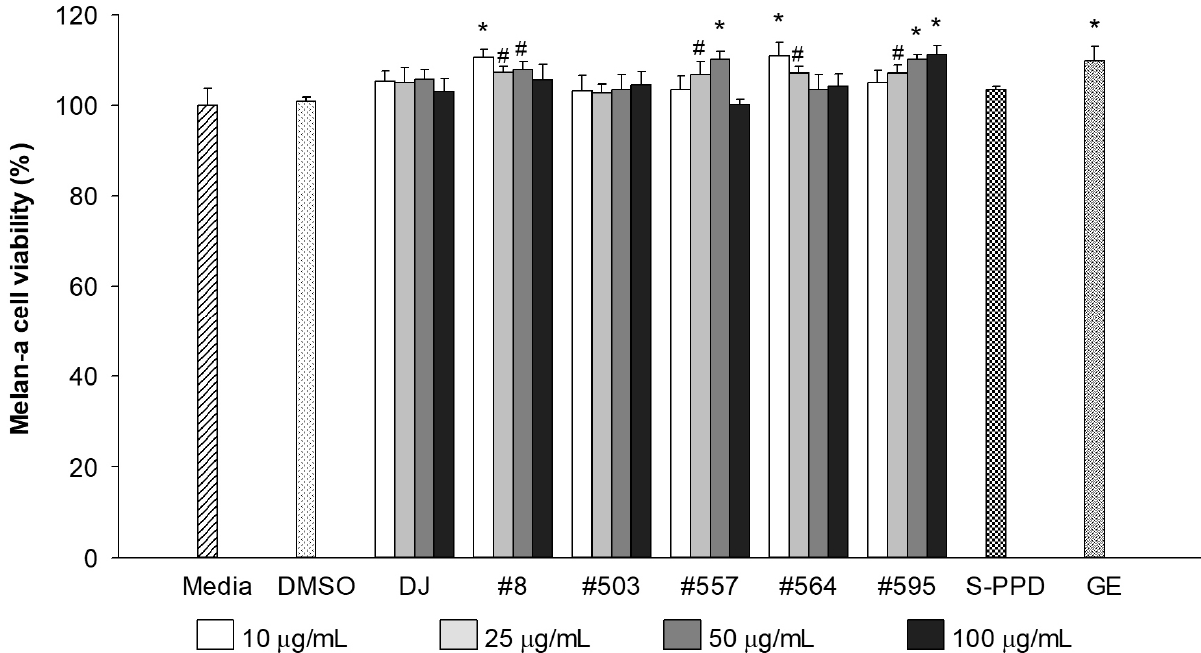
Figure 2. Effects of the PPD-enriched transgenic rice seed extracts on melan-a cell viability. DMSO, S-PPD, and GE concentrations were 0.1%, 700 pg/mL, and 100 µg/mL, respectively. Data are shown as mean ± standard deviation ( n = 3). Significant differences at p < 0.05 (#) and p < 0.01 (*) were determined via comparisons with the media group.